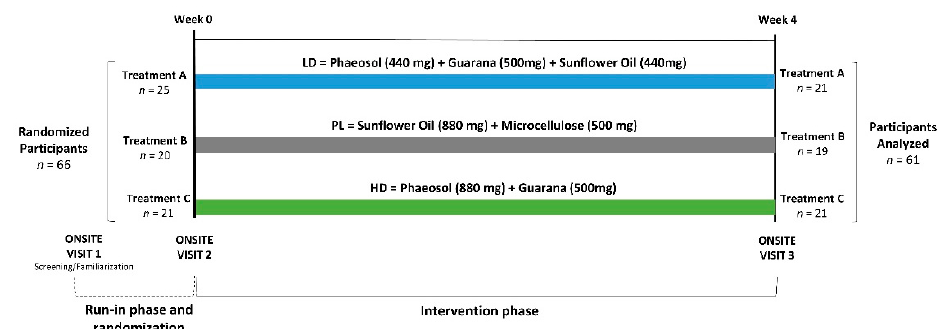
Figure 1. Overview of experiment study timeline for the placebo (PL), low-dose (LD), and high-dose (HD) groups.